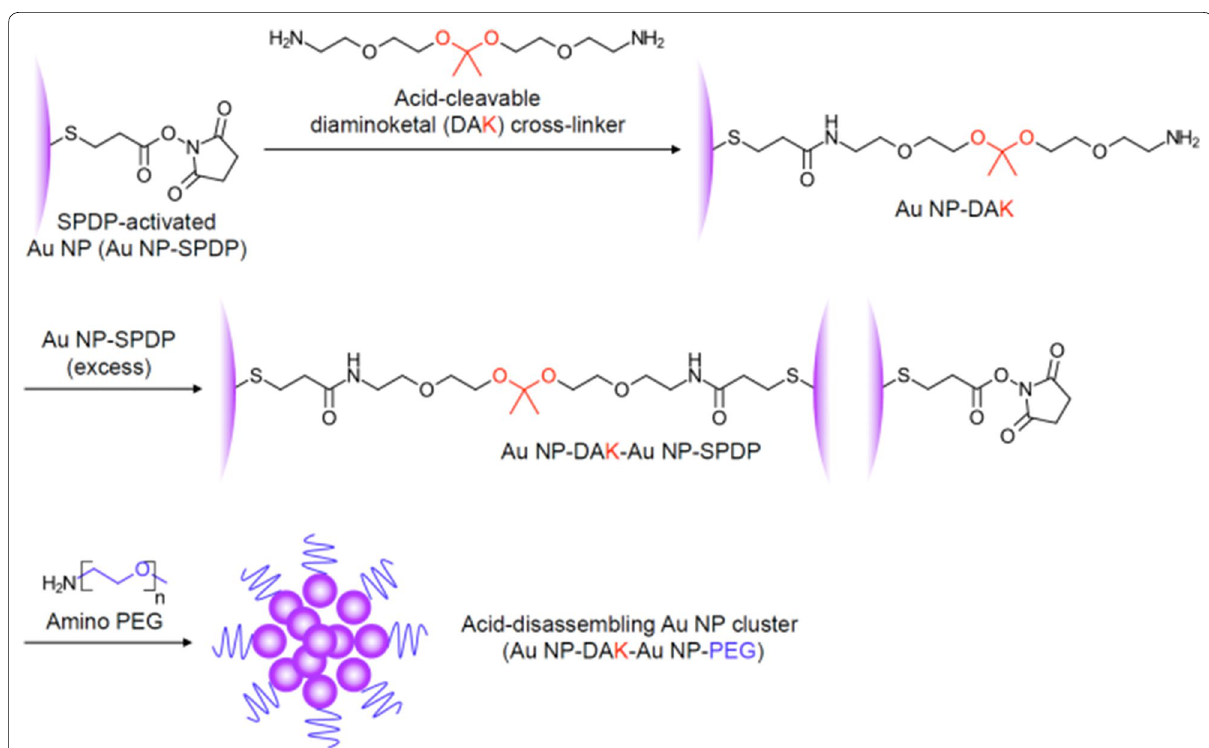
Fig. 2 Synthesis of acid‑degradable Au NCs. SPDP‑activated Au NPs were conjugated with acid‑cleavable diaminoketal (DAK) cross‑linkers. DAK cross‑linker‑conjugated Au NPs were then mixed with excess SPDP‑activated Au NPs to form clusters. The resulting Au NCs were PEGylated by reac‑ tion of amino PEG with the NHS group available on the surface of SPDP‑activated Au